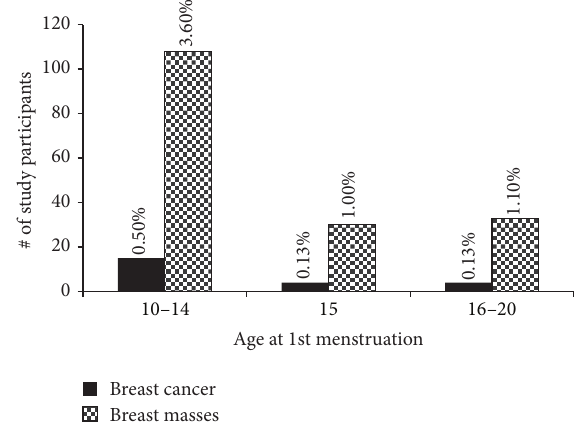
Figure 6: Incidence of breast cancer and breast mass relative to menarche. Study participants assessed for relationship between onset of menstruation and breast cancer are shown. Notably, participants who experienced early menarche were at a greater risk of breast disease. Table 3 further shows the corresponding histological classifications. 𝑃 < 0.005